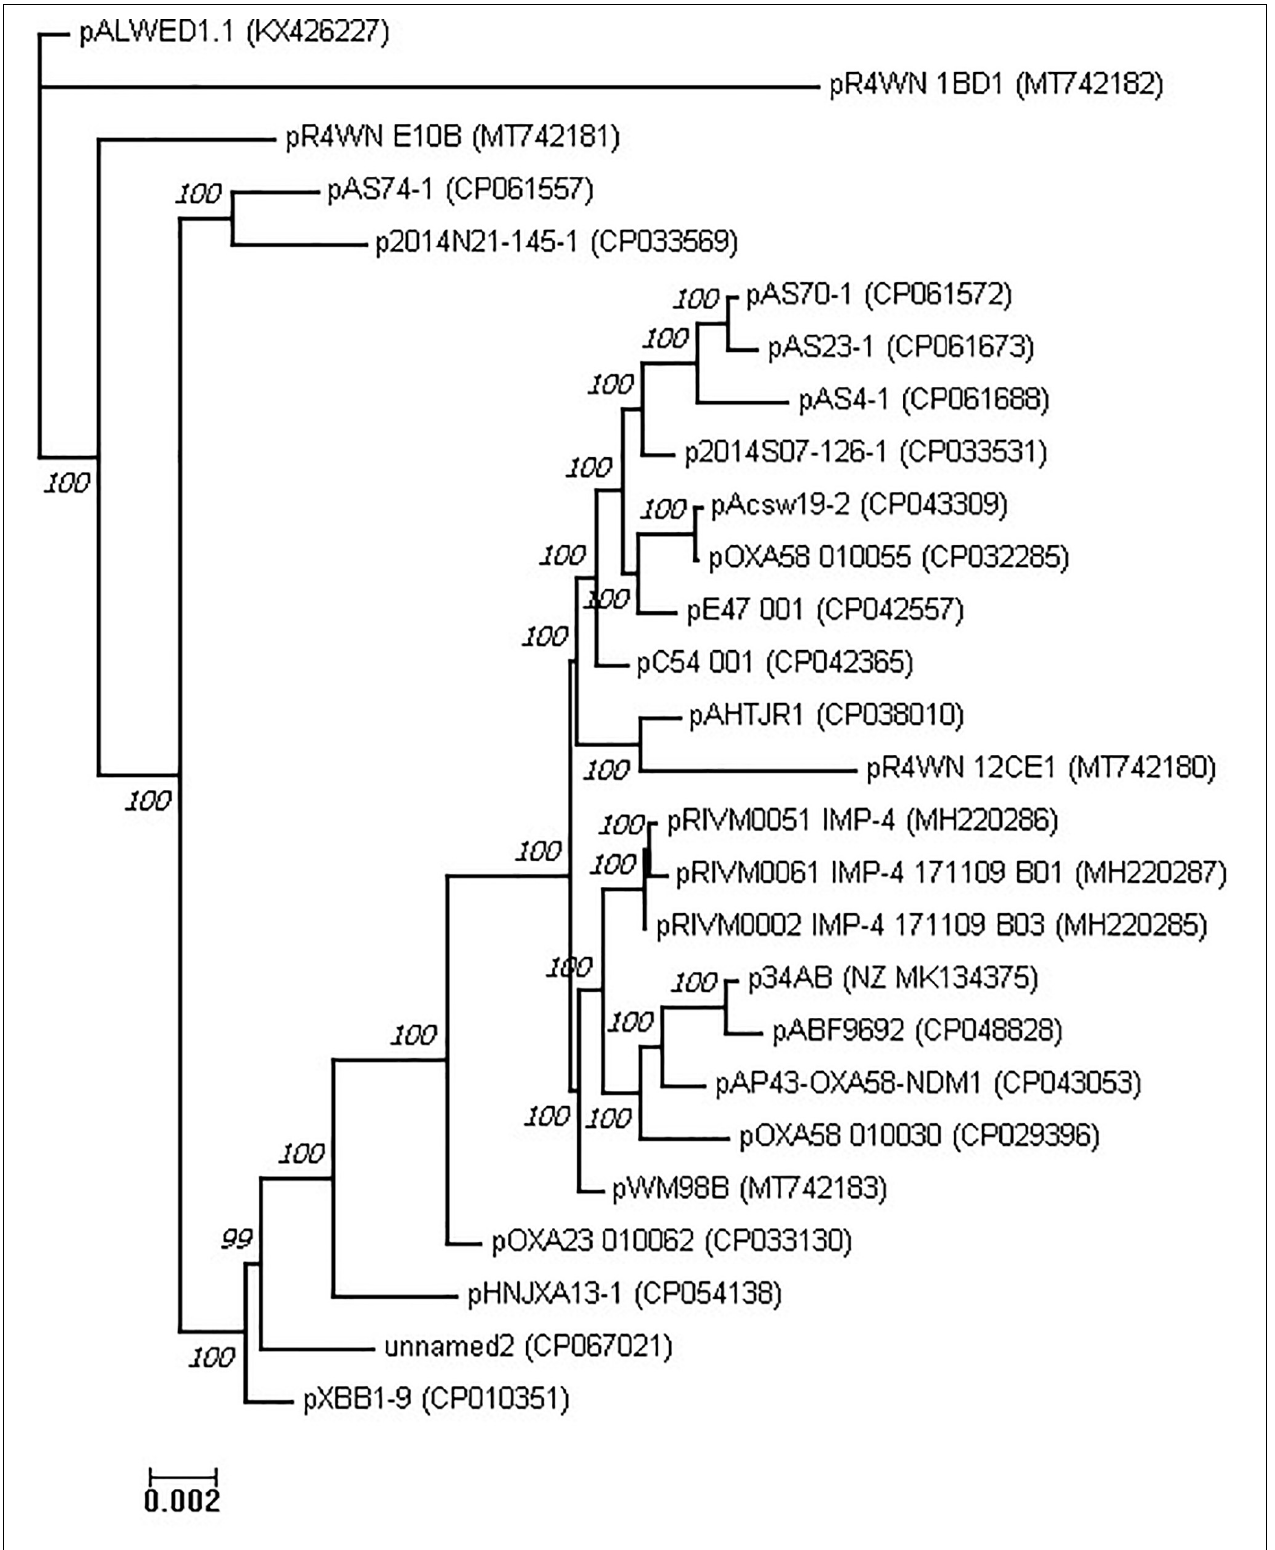
FIGURE 5 | Phylogenetic tree of Acinetobacter mega-plasmids (see section “Materials and Methods”).